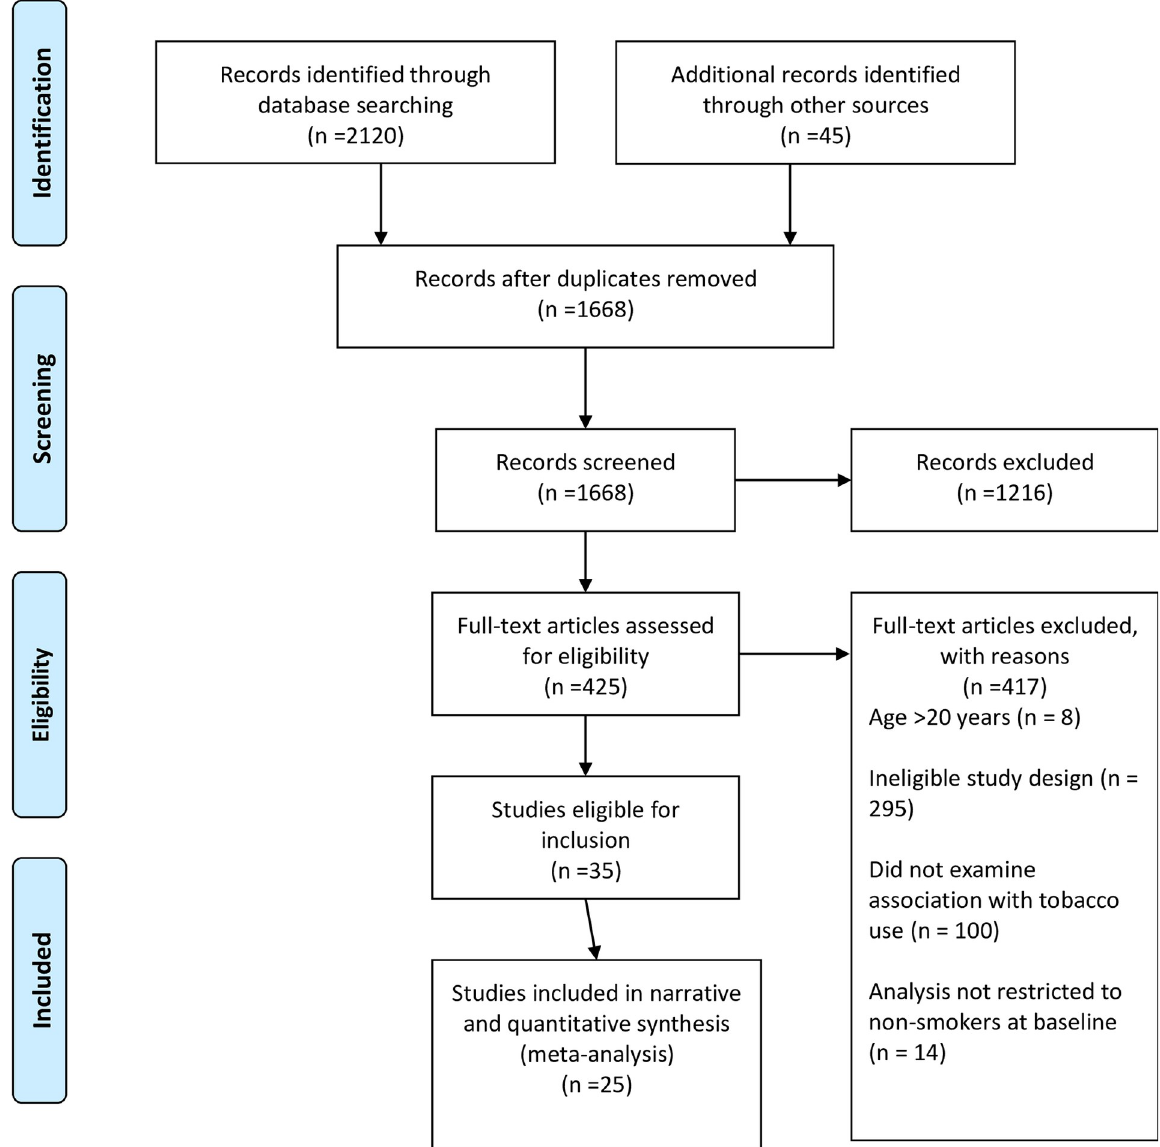
Fig 1. PRISMA flowchart outlining study inclusion and